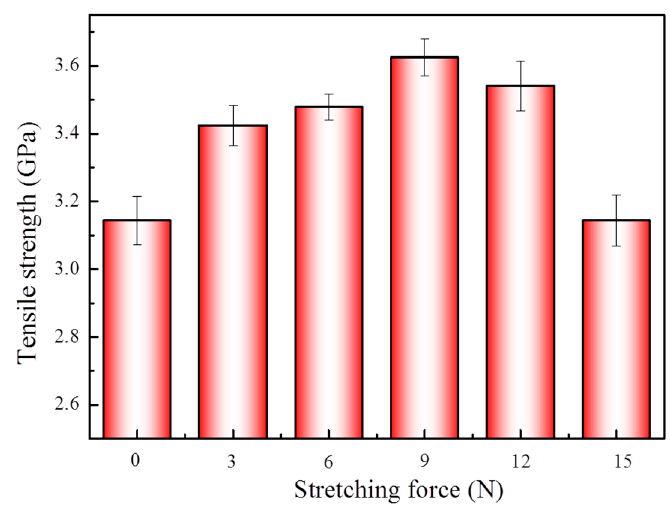
Figure 7. Tensile strength of the fiber treated with the 1,4-dichlorobutane in scCO 2 , under stretching